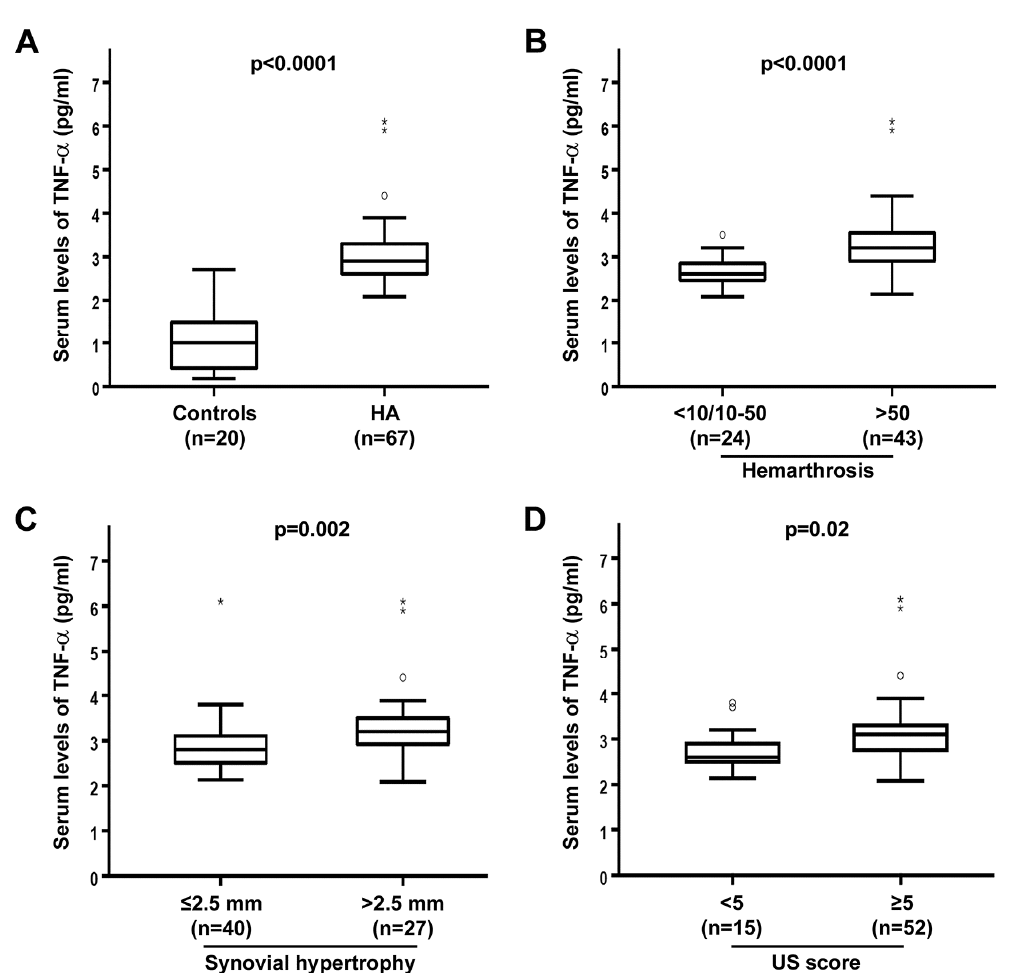
Figure 1. Increased circulating levels of tumor necrosis factor (TNF)- α in hemophilic arthropathy (HA). Serum concentrations of TNF- α were determined by colorimetric sandwich enzyme-linked immunosorbent assay in 67 patients with HA and 20 healthy controls. ( A ) Serum TNF- α levels in total HA patients and controls. ( B – D ) Serum TNF- α levels in HA patients stratified according to the number of hemarthroses ( B ), synovial hypertrophy ( C ), and ultrasound (US) score values ( D ). Boxes show 25th and 75th percentiles. Vertical lines below and above boxes show 10th and 90th percentiles. Lines inside the boxes represent the medians, circles the outliers, and asterisks the extreme values. Significant differences between groups are indicated. Mann–Whitney U-test was used for statistical analysis.